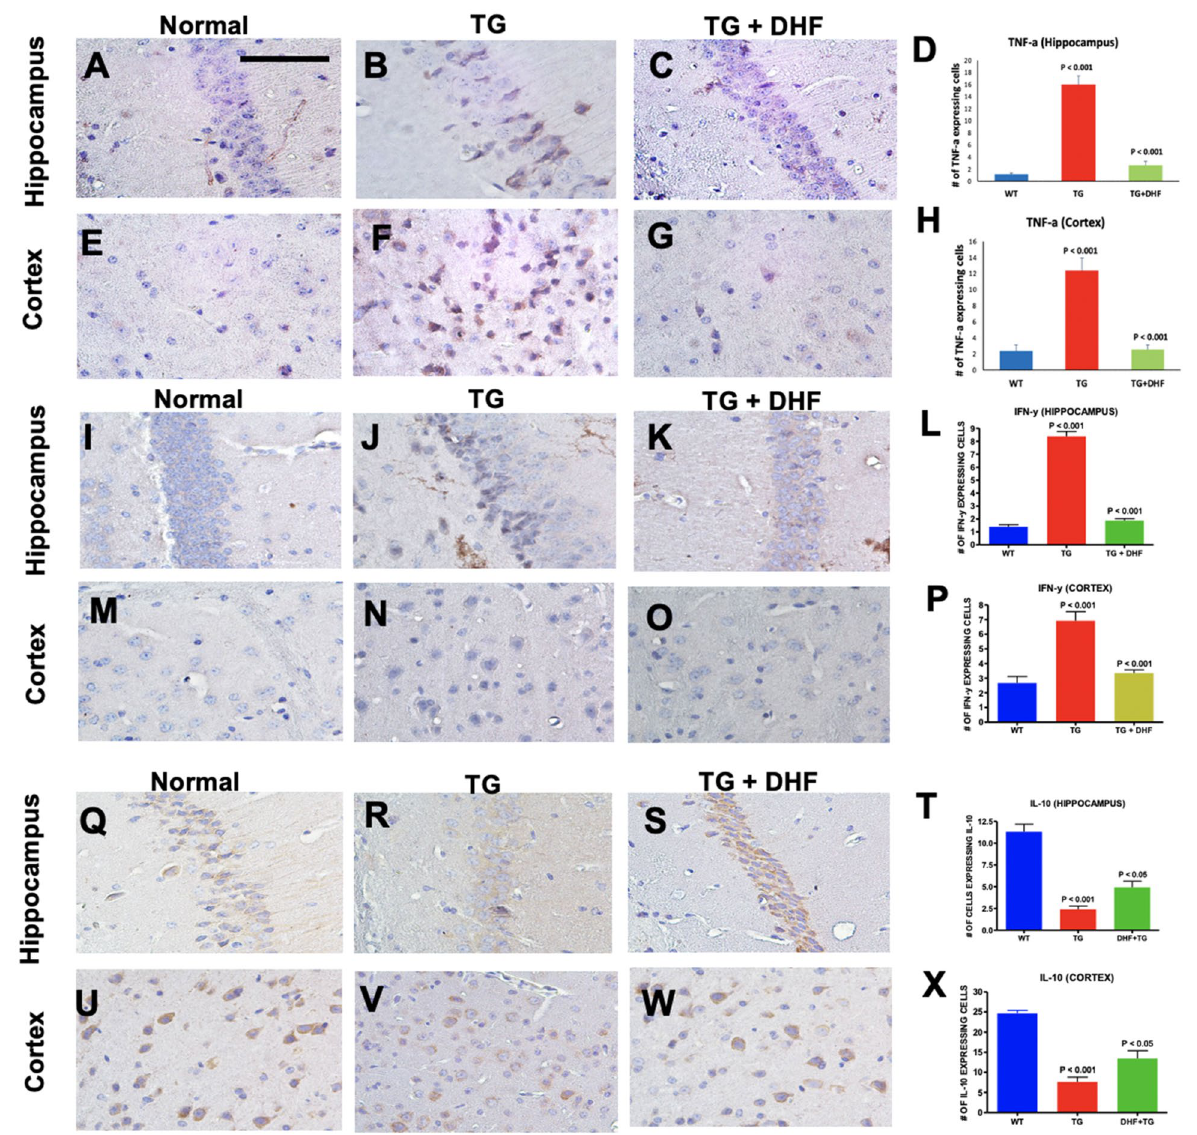
Figure 5. DHF treatment shifts the cytokine profile from Th1 towards Th2 response. Legend: TNF-a, IFN-y and IL-10 expression in the hippocampus and cortex of Wild Type (WT), Tg26, and DHF treated Tg26 mice ( A – X ). Immunohistochemical stained sections show TNF-a, IFN-y and IL-10 expressing cells in the hippocampal and cortex regions of the mice brains. 3 WT mice, 3 Tg26 mice, and 4 TG + DHF mice were used for TNF-a. 3 WT mice, 5 Tg26 mice, and 4 TG + DHF mice were used for IFN-y and IL-10. A, B, C, E, F, G, I, J, K, M, N, O, Q, R, S, U, V and W are 400 × magnification pictures of the hippocampus and cortex regions of the mice.